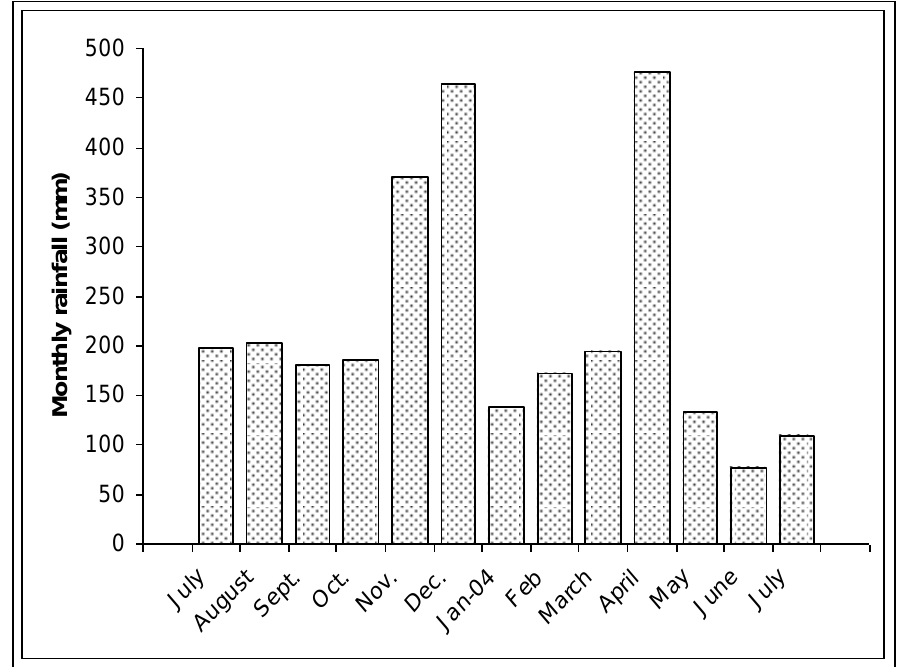
FIGURE 1. Rainfall pattern during the experimental period (July 2003 to July 2004).